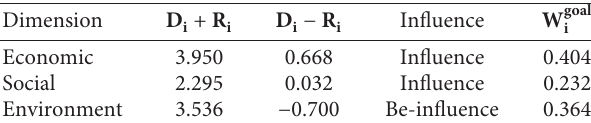
Table 26: Importance weight of sustainability dimensions in de- terministic condition.